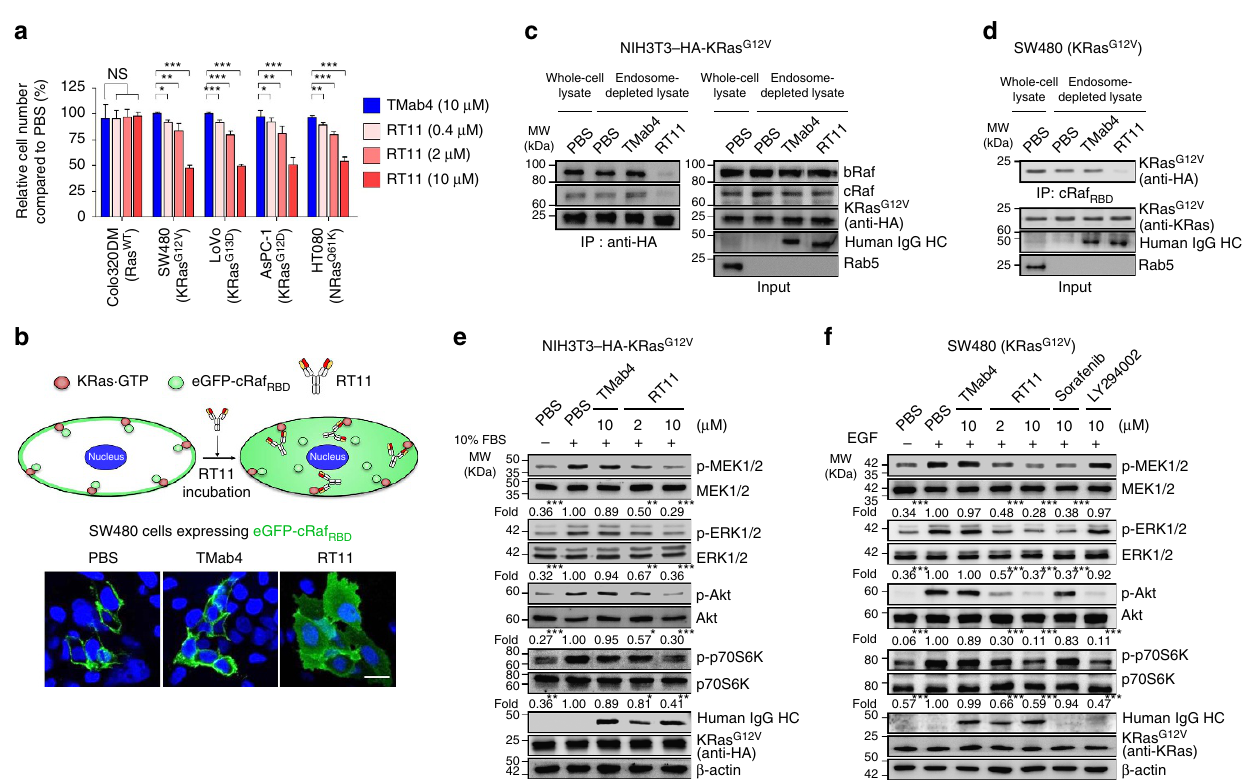
Figure 3 | RT11 inhibits the growth of oncogenic Ras mutant tumour cells by blocking PPIs between Ras and effector proteins. ( a ) Cellular proliferation assay, after cells were treated twice at 0 and 72h with antibody at the indicated concentrations for 6 d. Error bars ± s.d. ( n ¼ 3). * P o 0.05, ** P o 0.01, *** P o 0.001 versus TMab4-treated cells; NS, not significant. ( b ) Intracellular distribution of eGFP-fused cRaf RBD protein (green) in eGFP-cRaf RBD - transformed SW480 cells, treated with antibody (2 m M) for 12h before microscopic confocal analysis. Scale bar, 20 m m. ( c , d ) IP of endogenous Raf proteins (bRaf and cRaf) with HA-tagged KRas G12V from the endosome-depleted cell lysates of HA-KRas G12V -transformed NIH3T3 cells ( c ) and IP of endogenous KRas G12V with cRaf RBD from the endosome-depleted cell lysates of SW480 cells ( d ). The cells were treated with 2 m M of RT11 and TMab4 for 12h before analysis. ( e , f ) Inhibitory effect of RT11 on the downstream signalling of KRas-effector PPIs in HA-KRas G12V -transformed NIH3T3 cells ( e ) and SW480 cells ( f ), analysed by western blotting. The cells were serum-starved for 6h before treatment with antibody, Raf kinase inhibitor sorafenib, or PI3K-Akt inhibitor LY294002 for 6h in serum-free growth medium. Cells were washed and then stimulated with 10% FBS ( e ) and EGF (50ngml (cid:3) 1 in serum free-media) ( f ) for 10min before cell lysis. The number below the panel indicates relative value of band intensity of phosphorylated proteins compared to that in the PBS- treated control after normalization to the band intensity of respective total protein for each sample. * P o 0.05, ** P o 0.01, *** P o 0.001 versus PBS-treated control cells. In b – f , images are representative of at least two independent